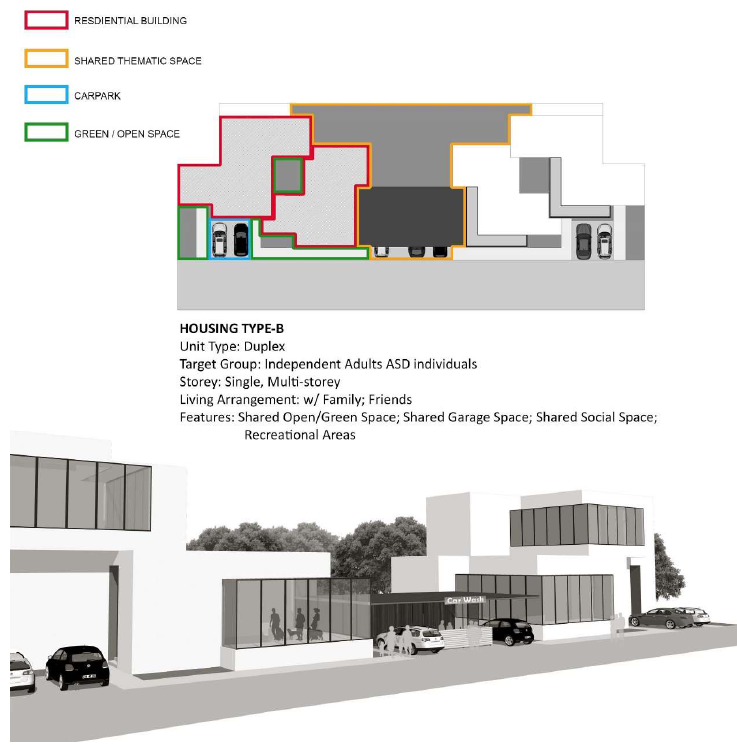
Figure 4. Proposed duplex units with shared interesting space.